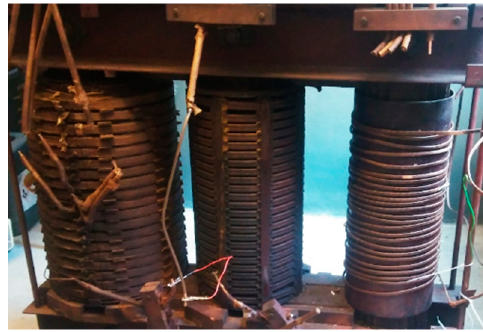
Figure 3. Physical model of the 24-turn coil prepared for the conducted research.